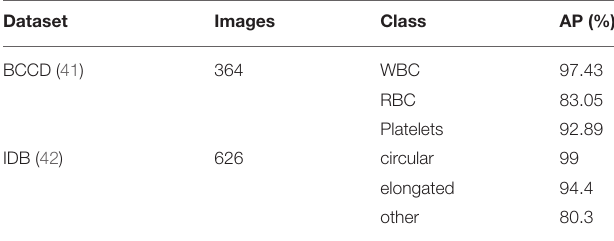
TABLE 8 | Comparison of the accuracy of the proposed method on different datasets.